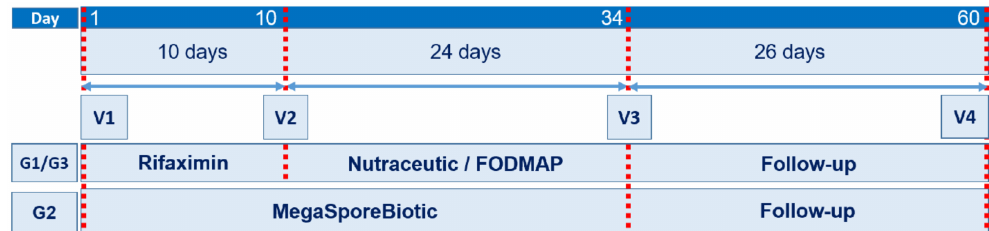
Figure 1. Study design. Treatment and follow-up periods with medical visits. Abbreviations: G = group, V =